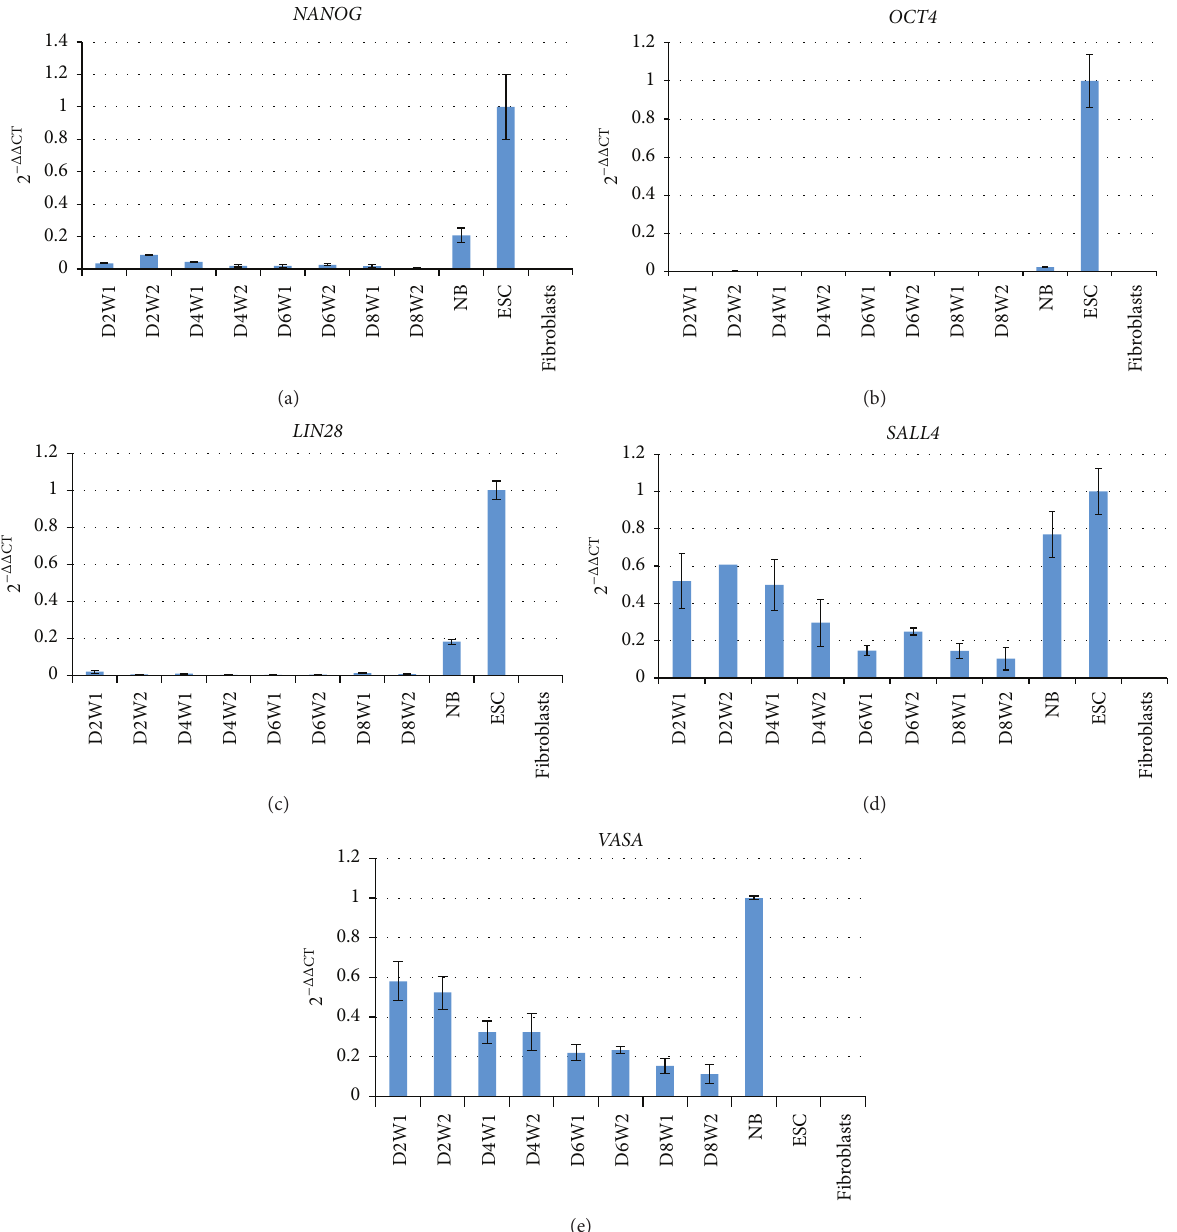
the last decade of ovarian germ cell research in